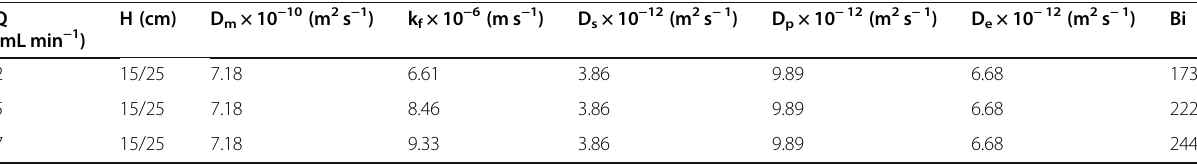
Table 8 Transport parameters at different operating